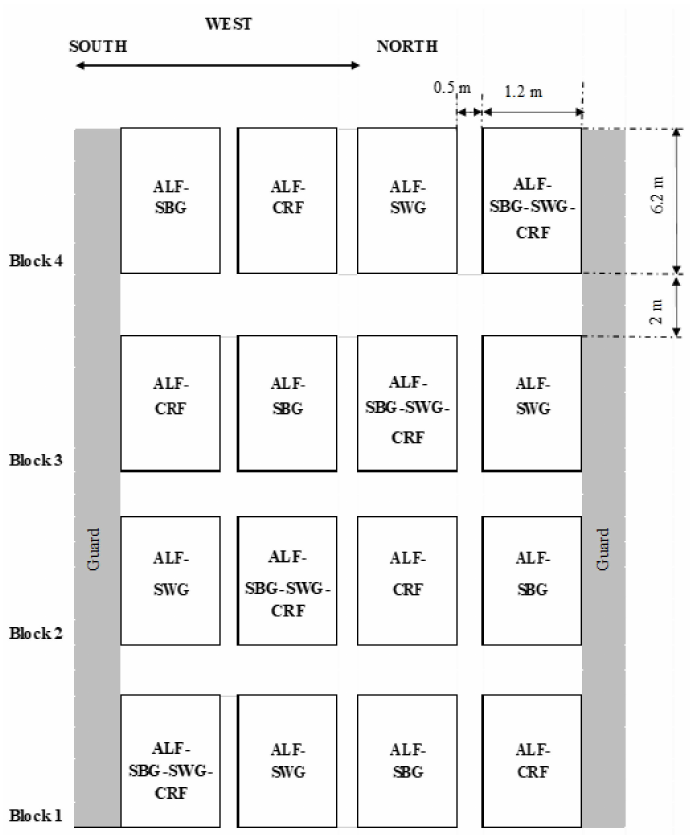
Figure 1. Experimental field layout of trial. Note: ALF, alfalfa cv. ‘Halo’; CMF, creeping meadow foxtail cv. ‘Garrison’; SBG, smooth bromegrass cv. ‘Radisson’; SWG, slender wheatgrass cv.